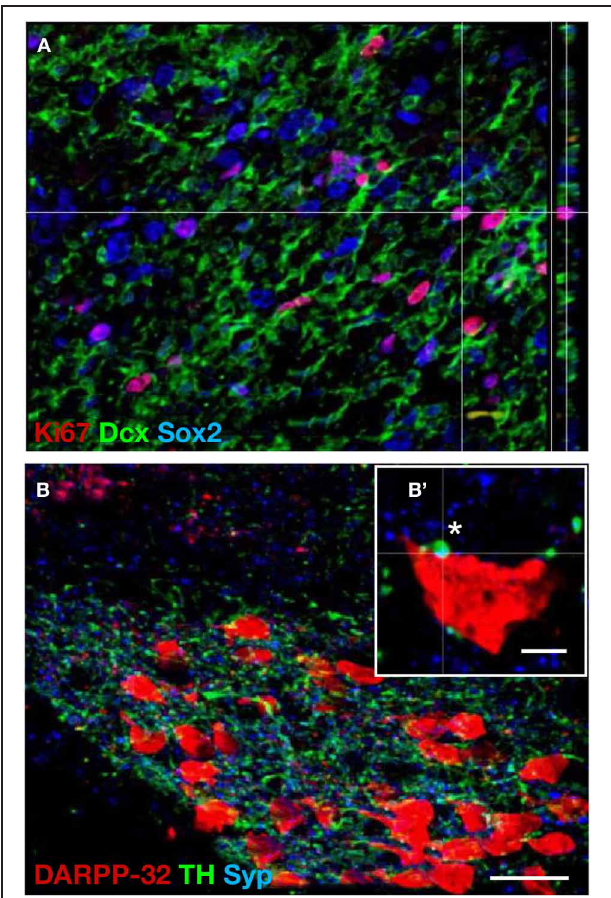
FIGURE 4 | Proliferation and integration of fetal striatal cells grafted in a HD brain. Photomicrographs illustrate human fetal WGE-derived graft in a post-mortem brain from a Huntington’s disease patient six month post-grafting. (A) A large portion of the graft consists of proliferative neural precursor cells shown by co-immunohistochemical labeling of the mitotic marker Ki67 (red), and the neural stem cells markers Doublecortin (green) and Sox2 (blue). (B) The graft shows a striatal phenotype displayed by large aggregates of DARPP-32 positive neurons. These aggregates are surrounded by a dense network of dopaminergic TH positive fibers. (B’) High magnification of a single graft-derived DARPP-32 positive neuron. A host-derived TH positive dopaminergic fiber forms a synapse with the grafted cell as shown by Synaptophysin co-labeling ( ∗ ). Dcx, Doublecortin; Syp, Synaptophysin. Scale bar in B = 30 μ m, scale bar in B (cid:4) = 5 μ m. Adopted from Capetian et al.